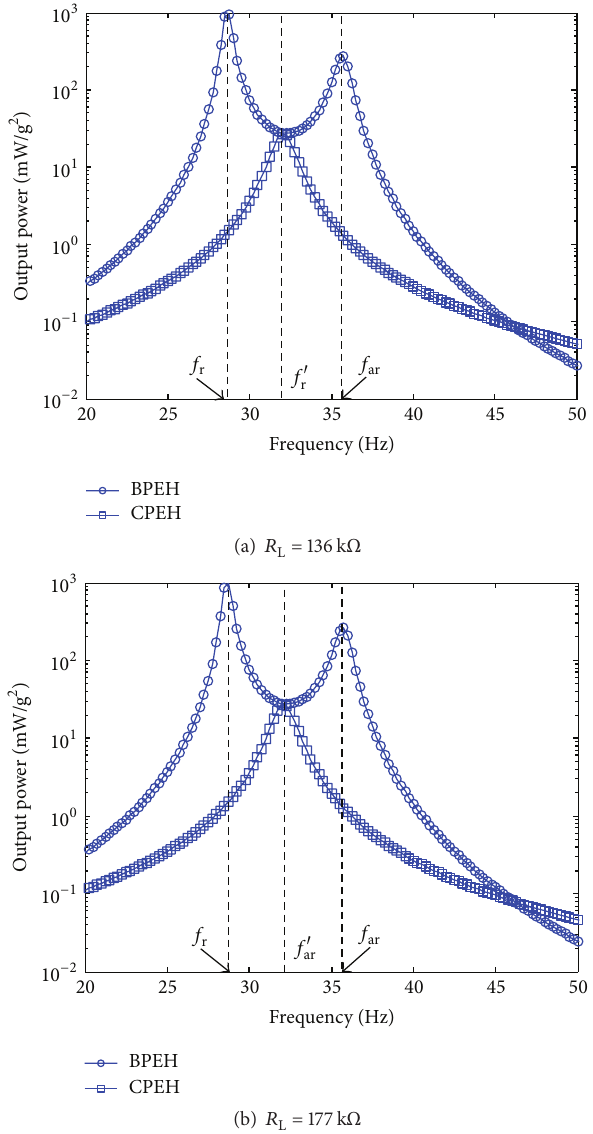
Figure 11: Optimal output power of BPEH versus vibration fre- quency for two optimal load resistances when 𝑔 = 1 and 𝑎 = 𝑟 = 20